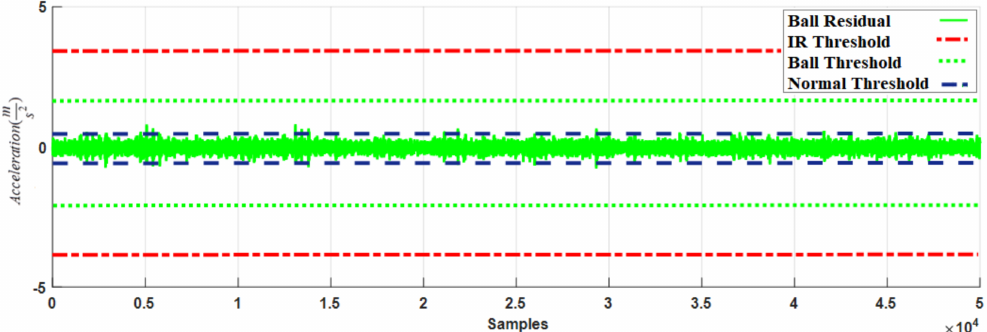
Figure 10. Residual of acceleration for ball fault signal: normal threshold ( ± 0.5), ball fault threshold ( ± 1.8), and inner fault threshold ( ± 3.5) for a crack width of 0.007.